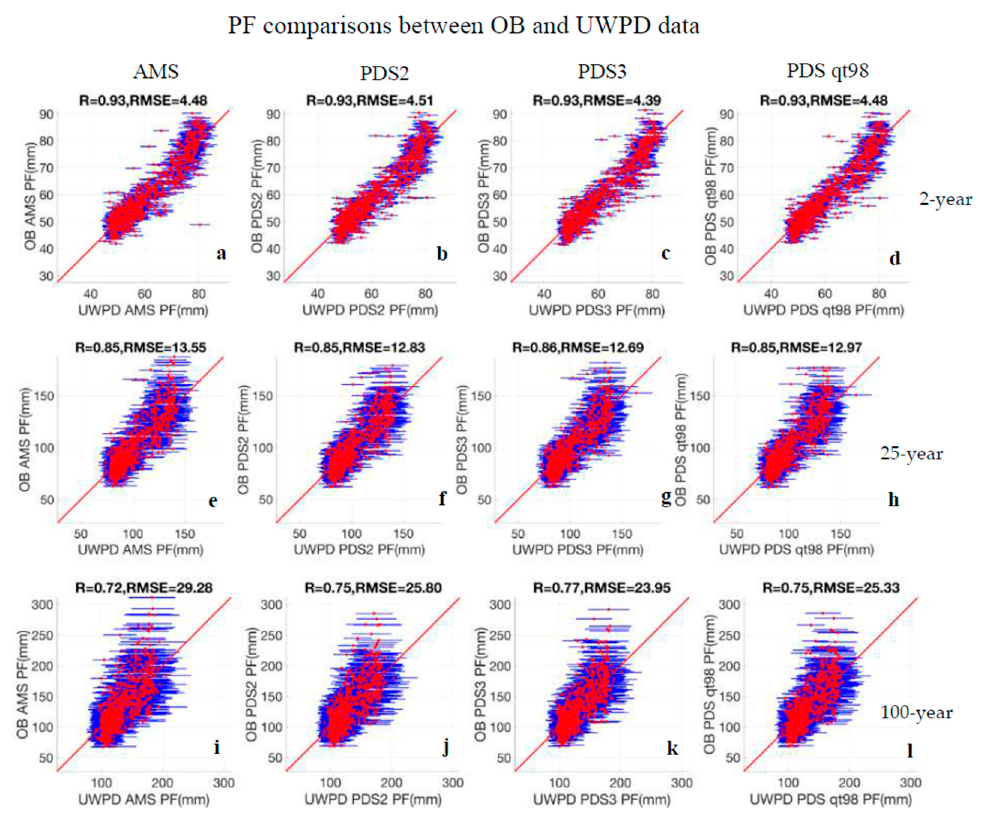
Figure 4. PF estimate comparisons between the observations and the UWPD data for return periods of 2 years (upper row), 25 years (middle row), and 100 years (lower row). The y -axis represents the PF estimates calculated based on observations, and the x -axis represents the PF estimates based on the downscaled data. For each station, an ensemble mean is represented by a red dot and the standard deviation is represented by a blue bar. Lines of “y = x” are also plotted for reference.